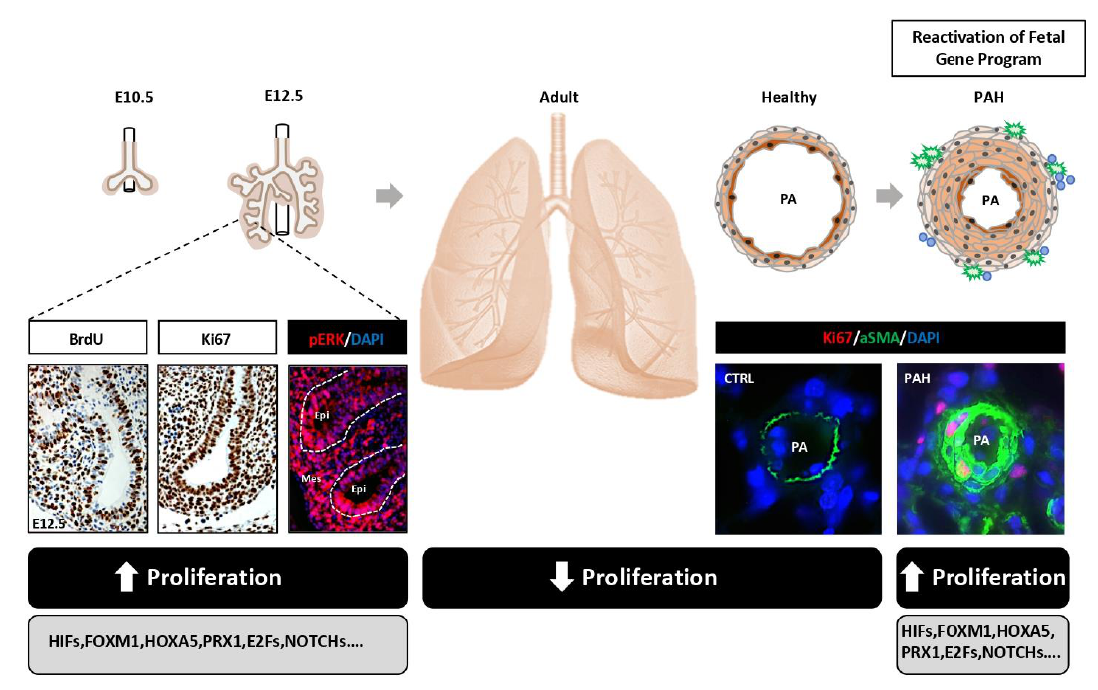
Figure 2. Scheme illustrating the concept of reactivation of genes devoted to promote fetal lung growth in PAH. A significant fraction of fetal genes fueling the explosive growth of the developing lung is reactivated/derepressed in PAH leading to pulmonary vascular remodeling and occlusion of distal pulmonary